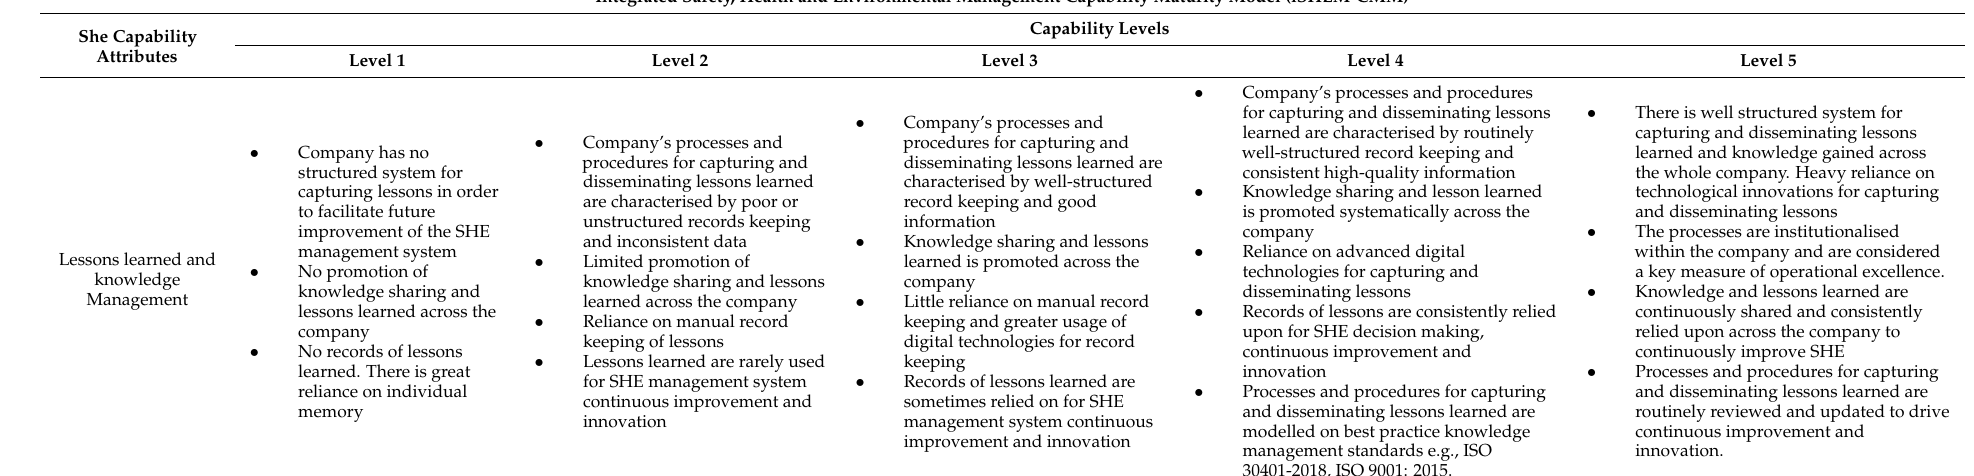
Table A1. Cont. Integrated Safety, Health and Environmental Management Capability Maturity Model